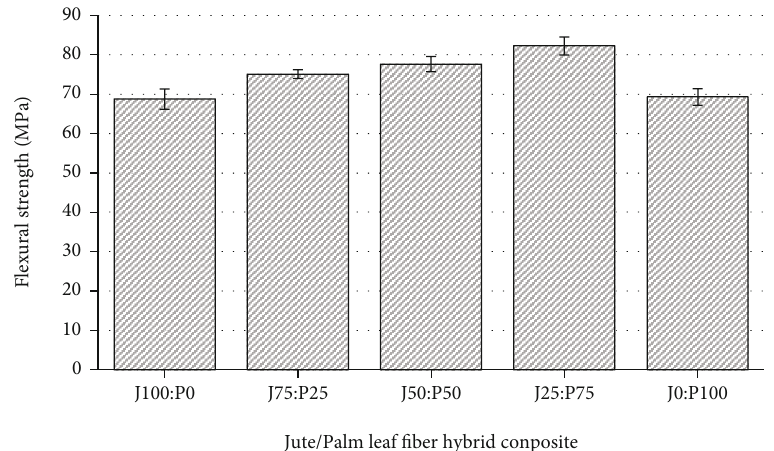
Figure 4: Flexural properties of jute/palm leaf-reinforced hybrid